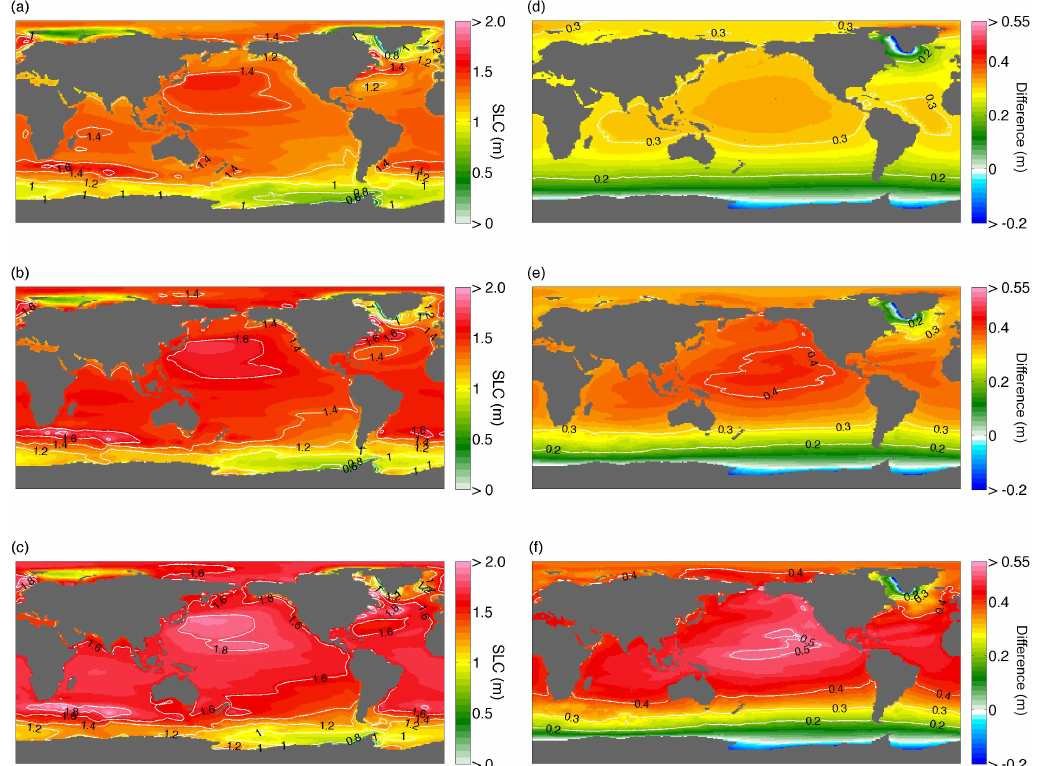
Figure 6. Sea level change (SLC) projections for high-end percentiles and the change therein by 2090. Left column: (a) 90th, (b) 95th and (c) 97.5th percentile for the asymmetric VW15 distribution of dynamical ice sheet mass loss combined with regional SLC projections following RCP8.5 (Slangen et al., 2014). Right column: difference between (d) 90th, (e) 95th and (f) 97.5th percentile for asymmetric VW15 and symmetric IPCC-based contribution, both combined with regional SLC projections following RCP8.5 (Slangen et al., 2014). Percentiles for the symmetric IPCC-based probability distribution are depicted in Fig.